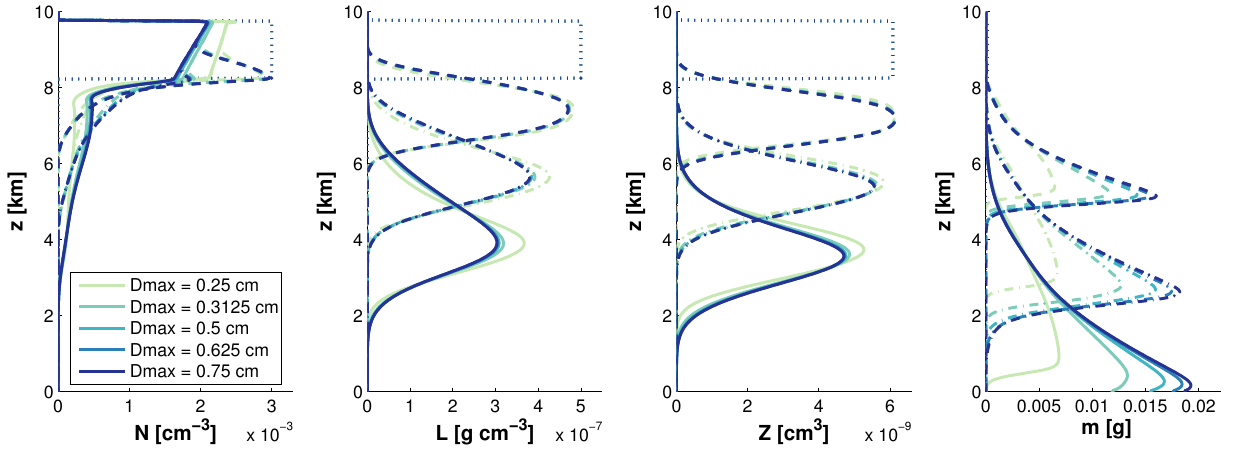
Figure A1. Profiles of N , L , Z and m using the B -Distribution and a constant value of x Equation (A8). The legend gives the corresponding maximum drop diameters. Line styles for time steps (every 300 s) are as in Figure